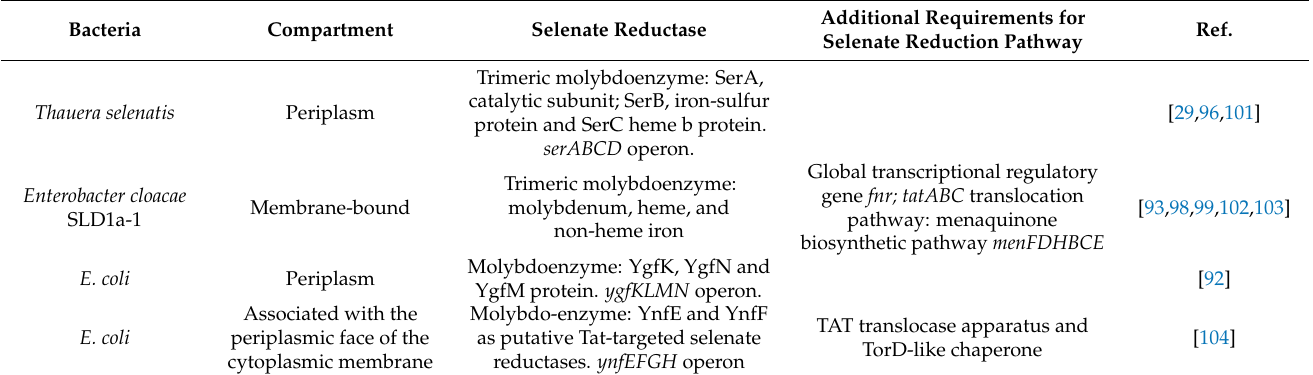
Table 3. Conditions involved in the reduction of selenate to selenite in anaerobic